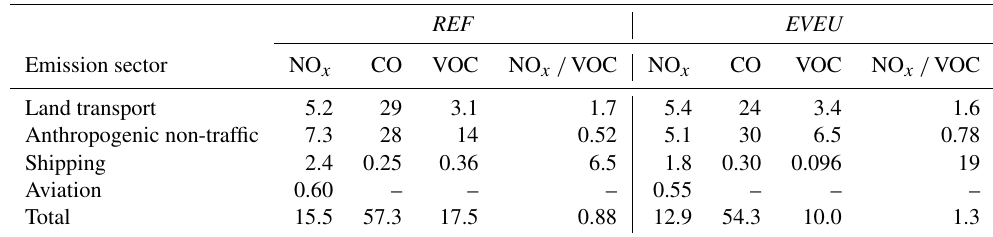
Table 5. Average (2008 to 2010) annual total emissions for the CM50 domain of different anthropogenic emission sectors and the total of all emission sectors for NO x (in Tg ( NO ) a − 1 ), CO (Tg ( CO ) a − 1 ), VOC (Tg ( C ) a − 1 ), and the NO x to VOC ratio (NO x /